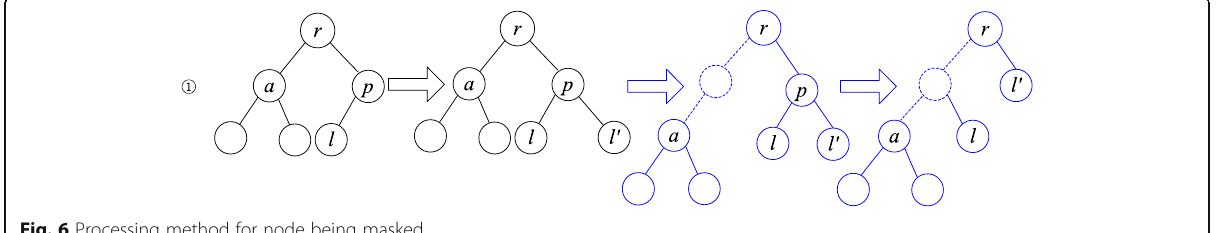
Fig. 6 Processing method for node being